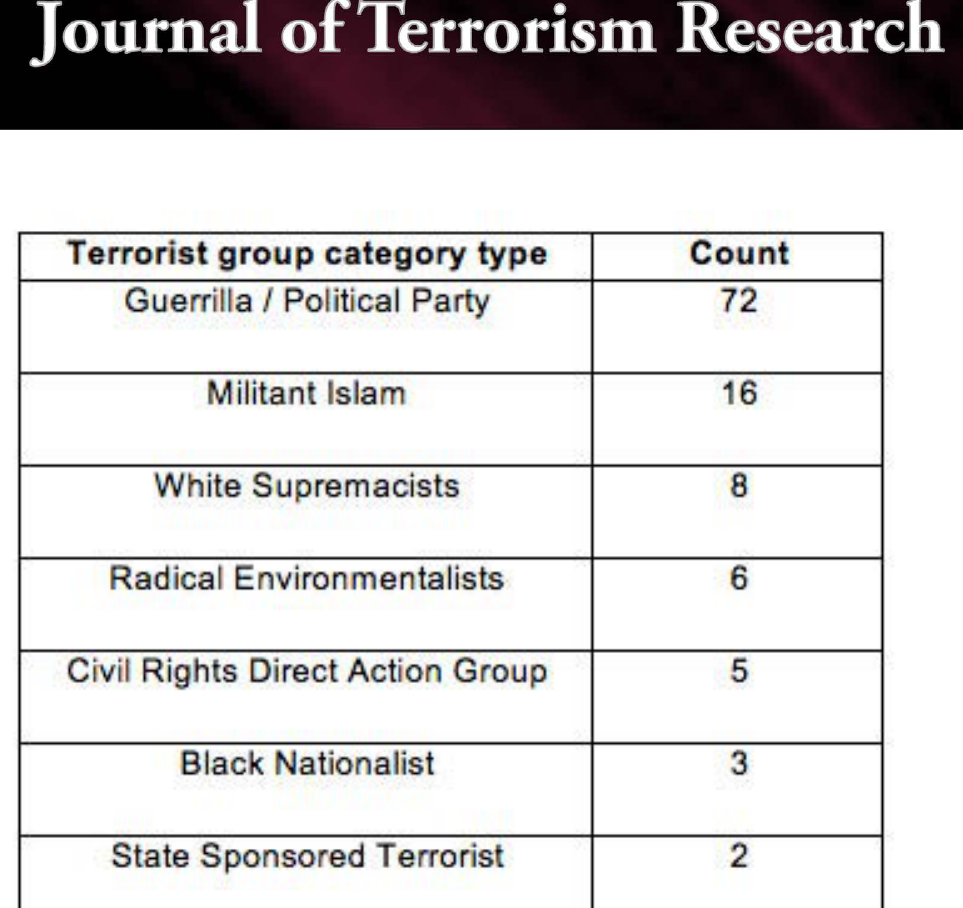
Figure 1: Terrorist category group type mapped to website